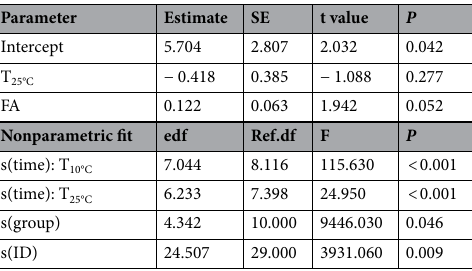
Table 1. Summary of GAMM model testing for M b . Parameter estimates of general additive mixed model (GAMM) describing the effects of forearm length (FA), treatment (T 10°C and T 25°C ) and day since capture (time) on body mass (M b ). Bat ID (ID) and group were included as random effects. Adjusted R 2 = 0.851, scale estimates = 0.17776, n =